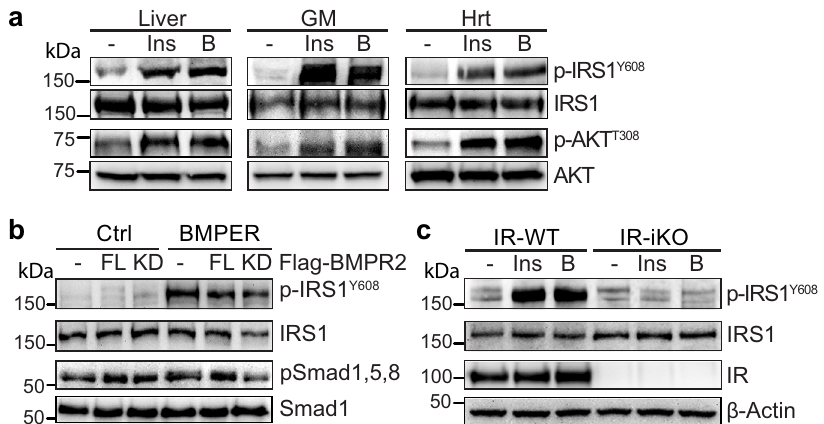
Fig. 4 BMPER promotes insulin signaling through IR but not BMPR2. a BMPER (B, 1 h) or insulin (Ins, 0.5 h) was injected ( i.p .) into mice. Tissues, including liver, GM (gastrocnemius muscle), and Hrt (heart), were used for Western blotting. b Hepatocytes were transduced with adenovirus of fl ag- tagged BMPR2 full-length (FL) or kinase-dead mutant (KD). Cells were then treated with BMPER (1 h) and harvested for Western blotting. c Hepatocytes were isolated from IR-iKO and their littermate control (IR-WT) mice. Cells were treated with insulin (Ins, 0.5 h) or BMPER (B, 1 h) and harvested